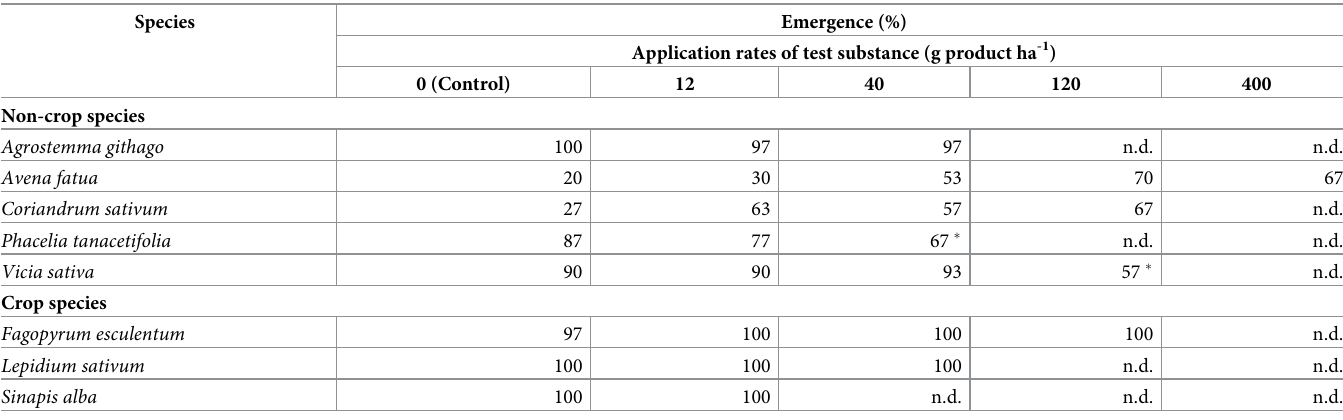
Table 6. Germination rate in % of harvested seeds (F1).